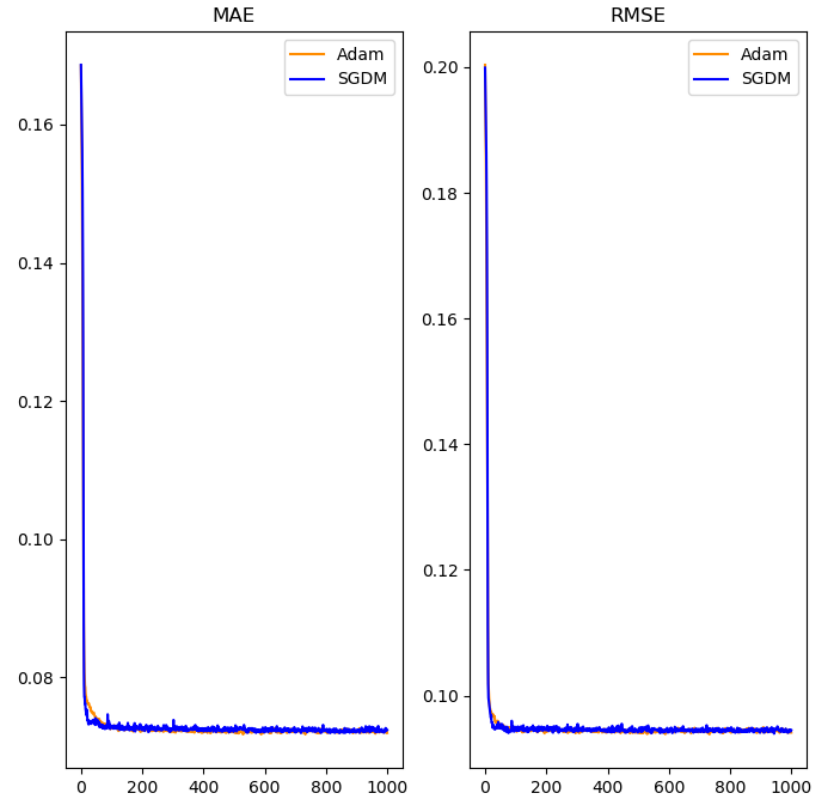
Figure 11. The comparison of Adam and SGDM algorithm. After 1000 iterations, the Adam algorithm and the SGDM algorithm had quite similar training curves, with mean absolute errors of 0.0713 and 0.0709, and root mean square errors of 0.0917 and 0.0905, respectively. Although there was not much difference between the two, the SGDM algorithm reduced the loss slightly more effectively than the Adam algorithm. The detailed optimal training process is shown in Table 4. Table 4. Best training results of neural network classes.